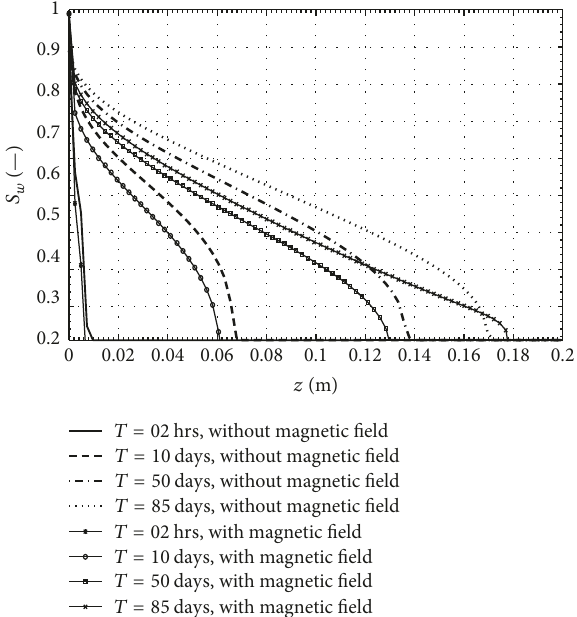
Figure 4: Saturations profiles against the core length with and without magnetic field effect for various values of imbibition time: magnet is placed on the right side of the